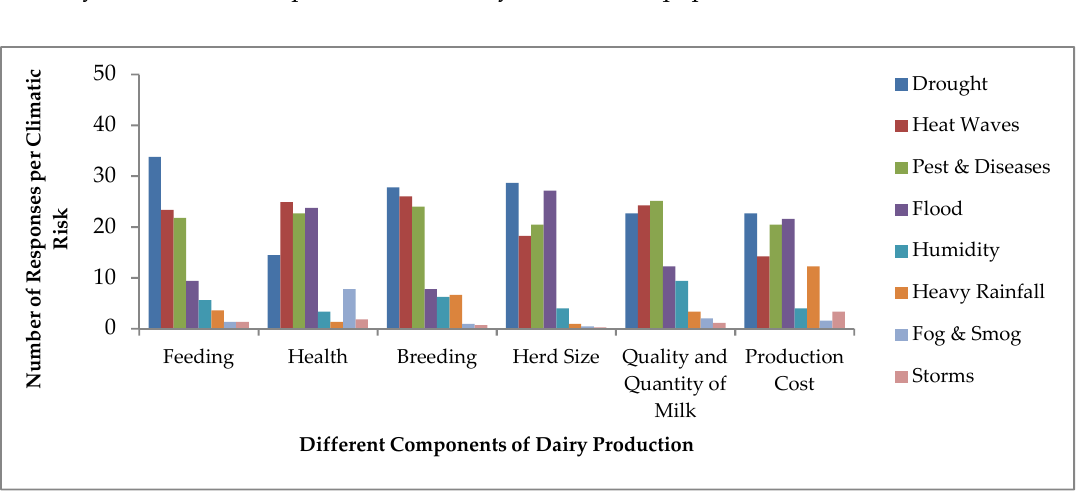
Figure 7. Perceived impacts of climatic risks on dairy farming system